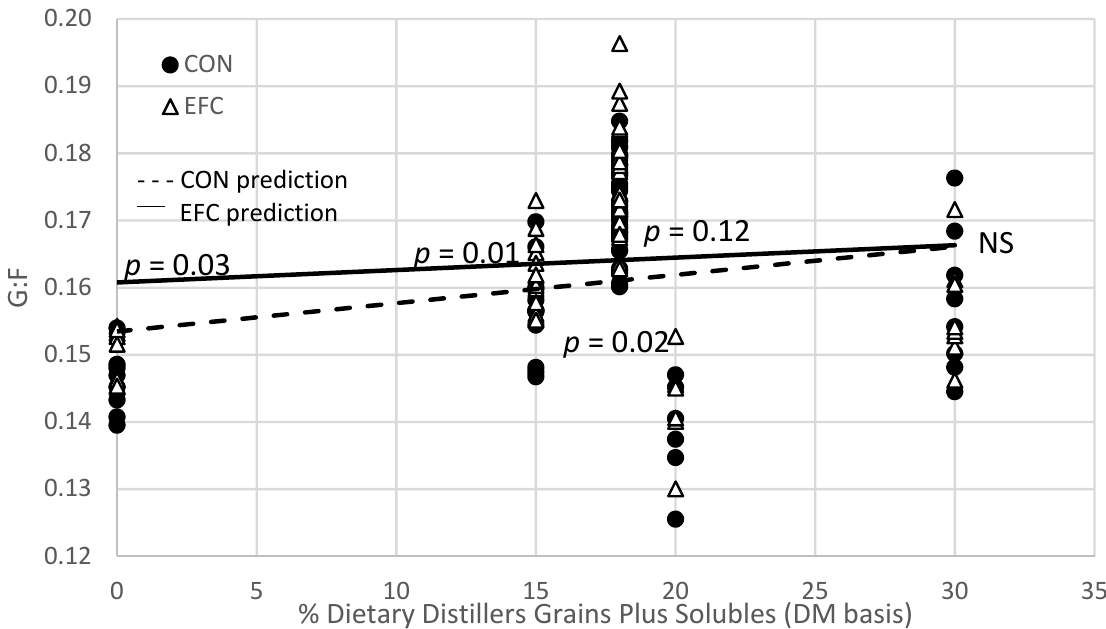
Figure 1. Linear interaction between corn hybrid (CON vs. EFC) fed as dry-rolled corn and distiller grains plus solubles inclusion rate for G:F.